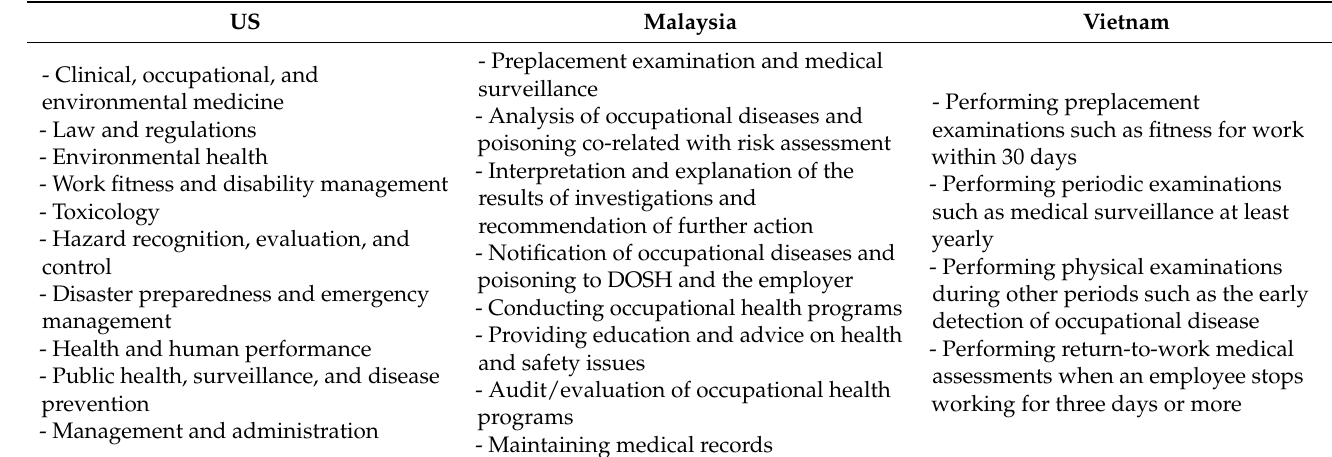
Table 2. Duties of occupational